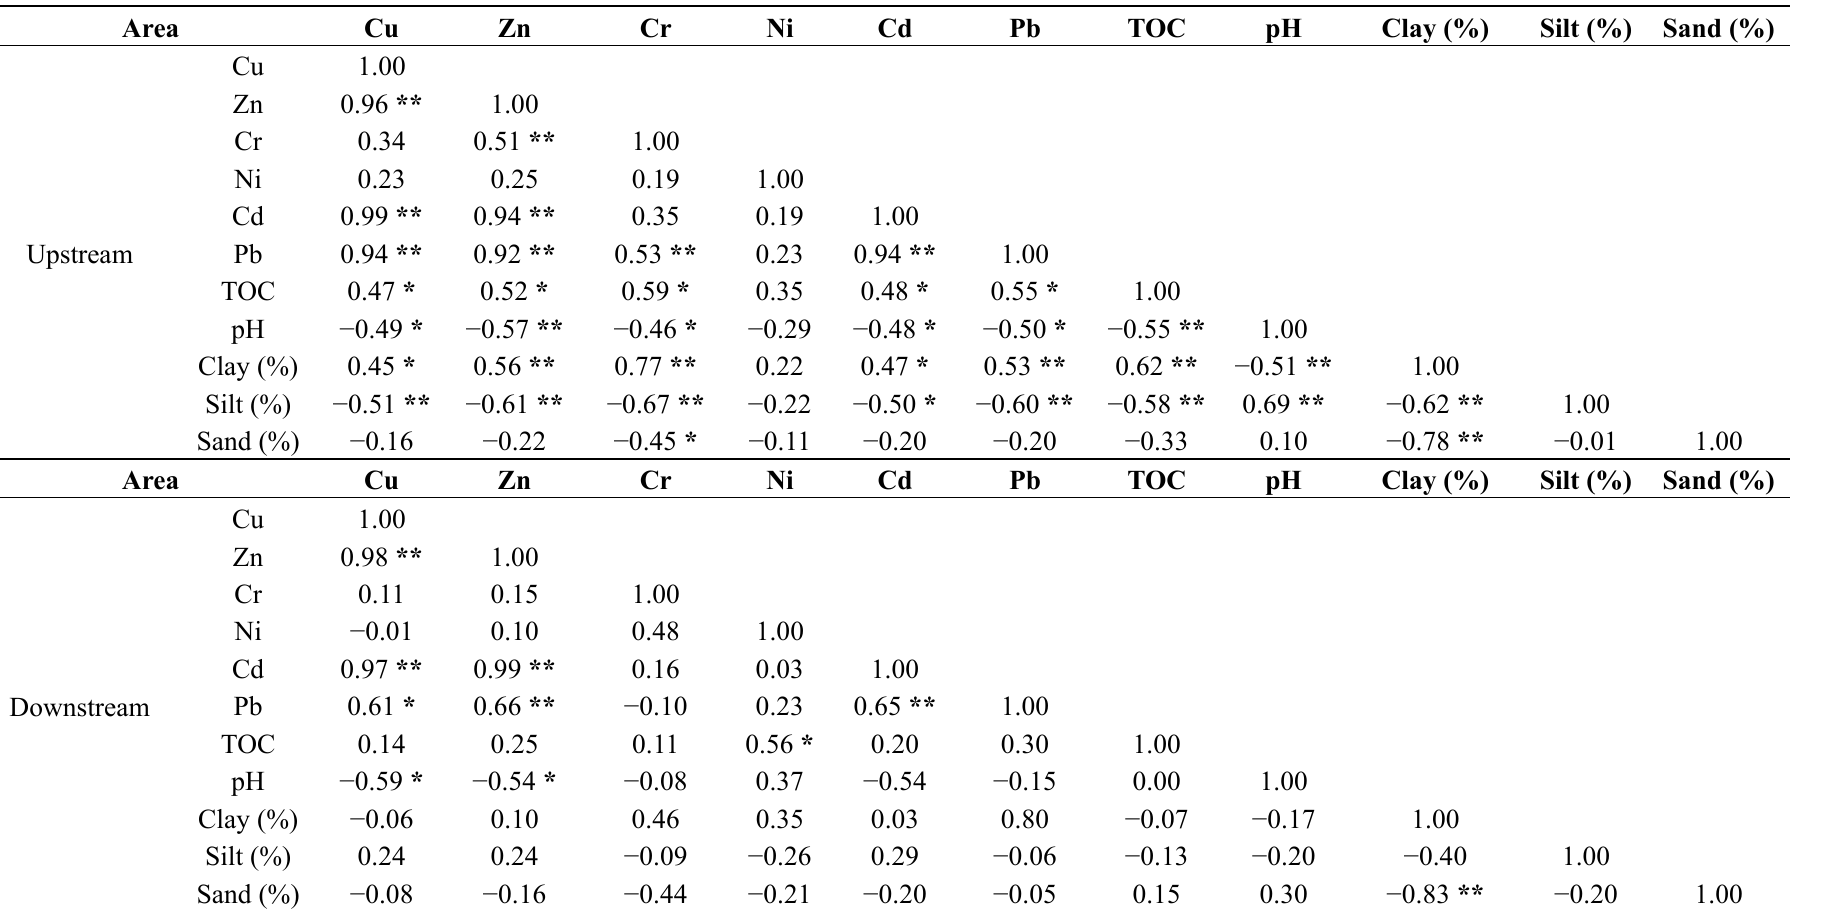
Table 3. Correlation analysis of metals among all sampling